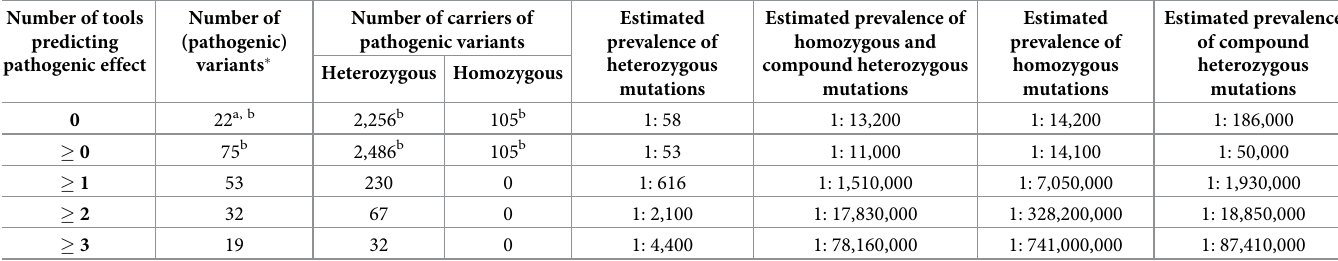
Table 2. Estimated prevalence of hetero- and homozygous as well as compound heterozygous variants across all populations. Number of tools